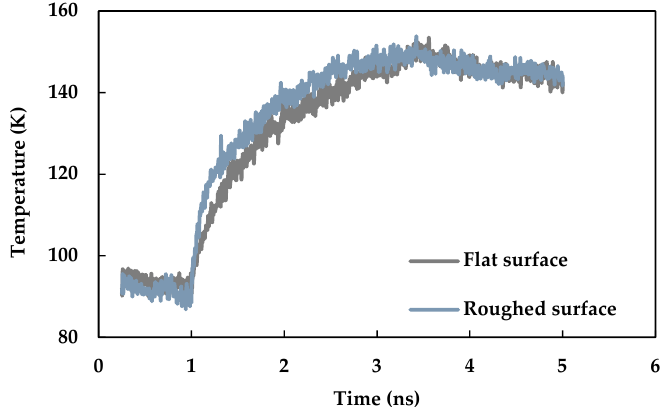
Figure 19. Comparison of temperature history of the argon atoms for nano level roughed surface with a smooth surface.